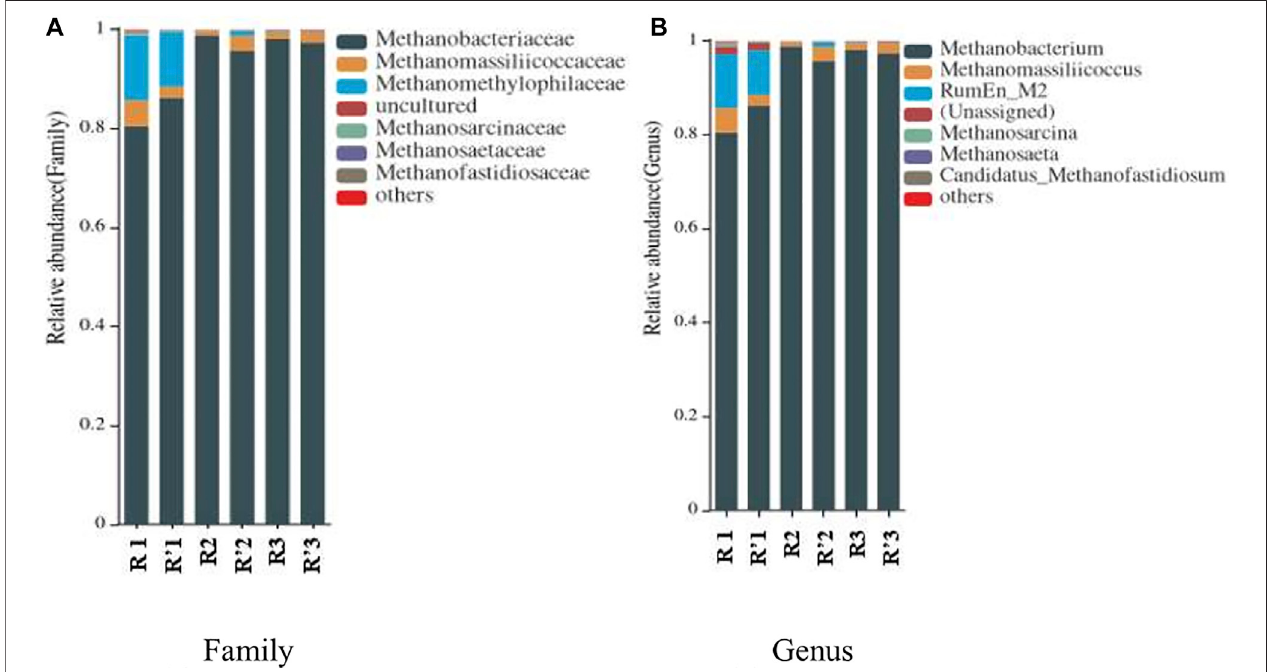
FIGURE 6 | Relative abundance of archaeal communities at different taxonomic levels. (A) The family level and (B) the genus